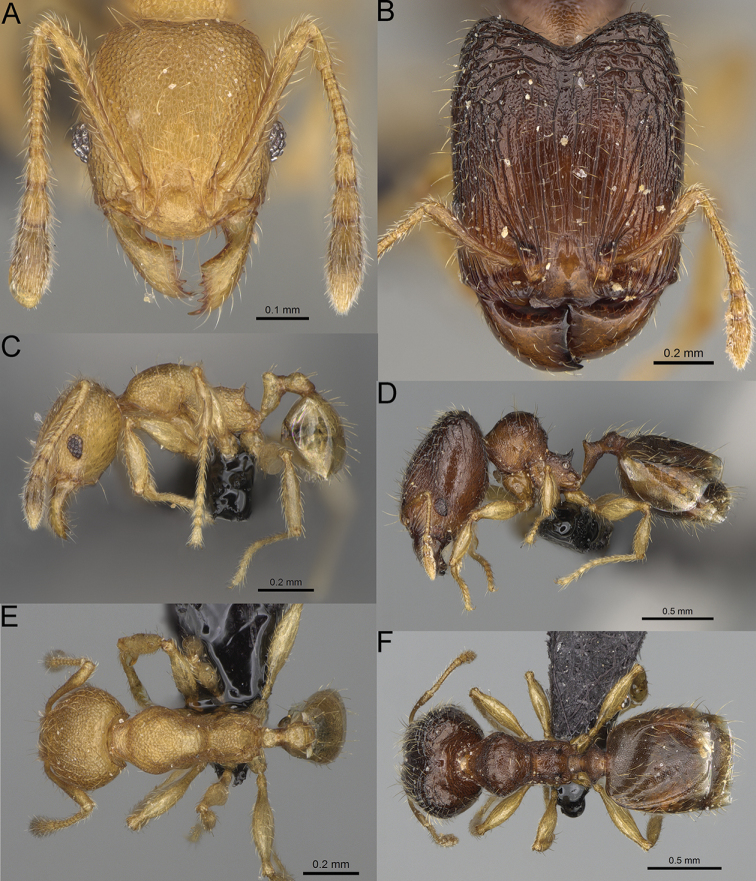
Pheidole
avaratra sp. nov., full-face view (A), profile (C), and dorsal view (E) of paratype minor worker (CASENT0923184) and full-face view (B), profile (D), and dorsal view (F) of holotype major worker (CASENT0107719).